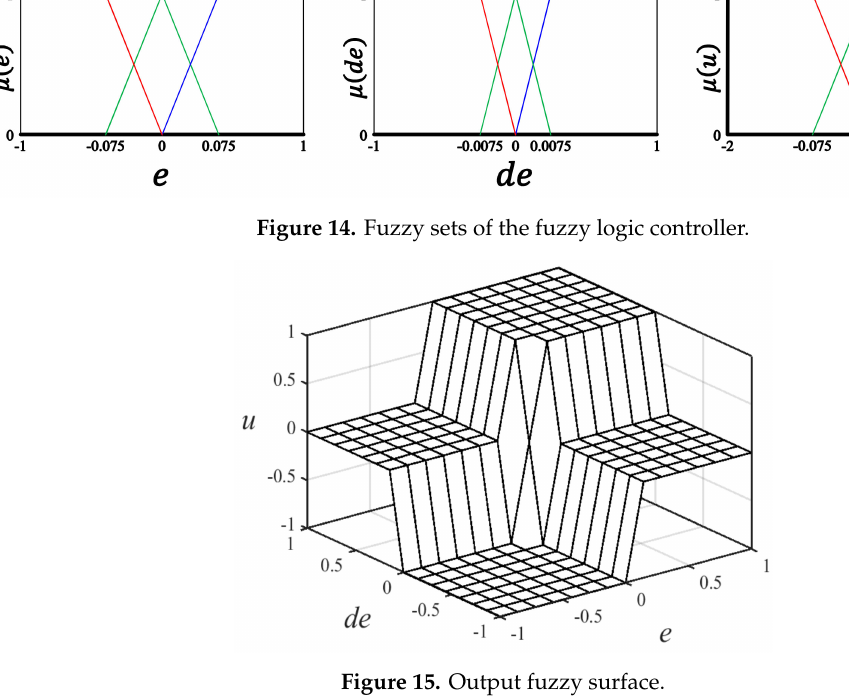
Figure 15. Output fuzzy